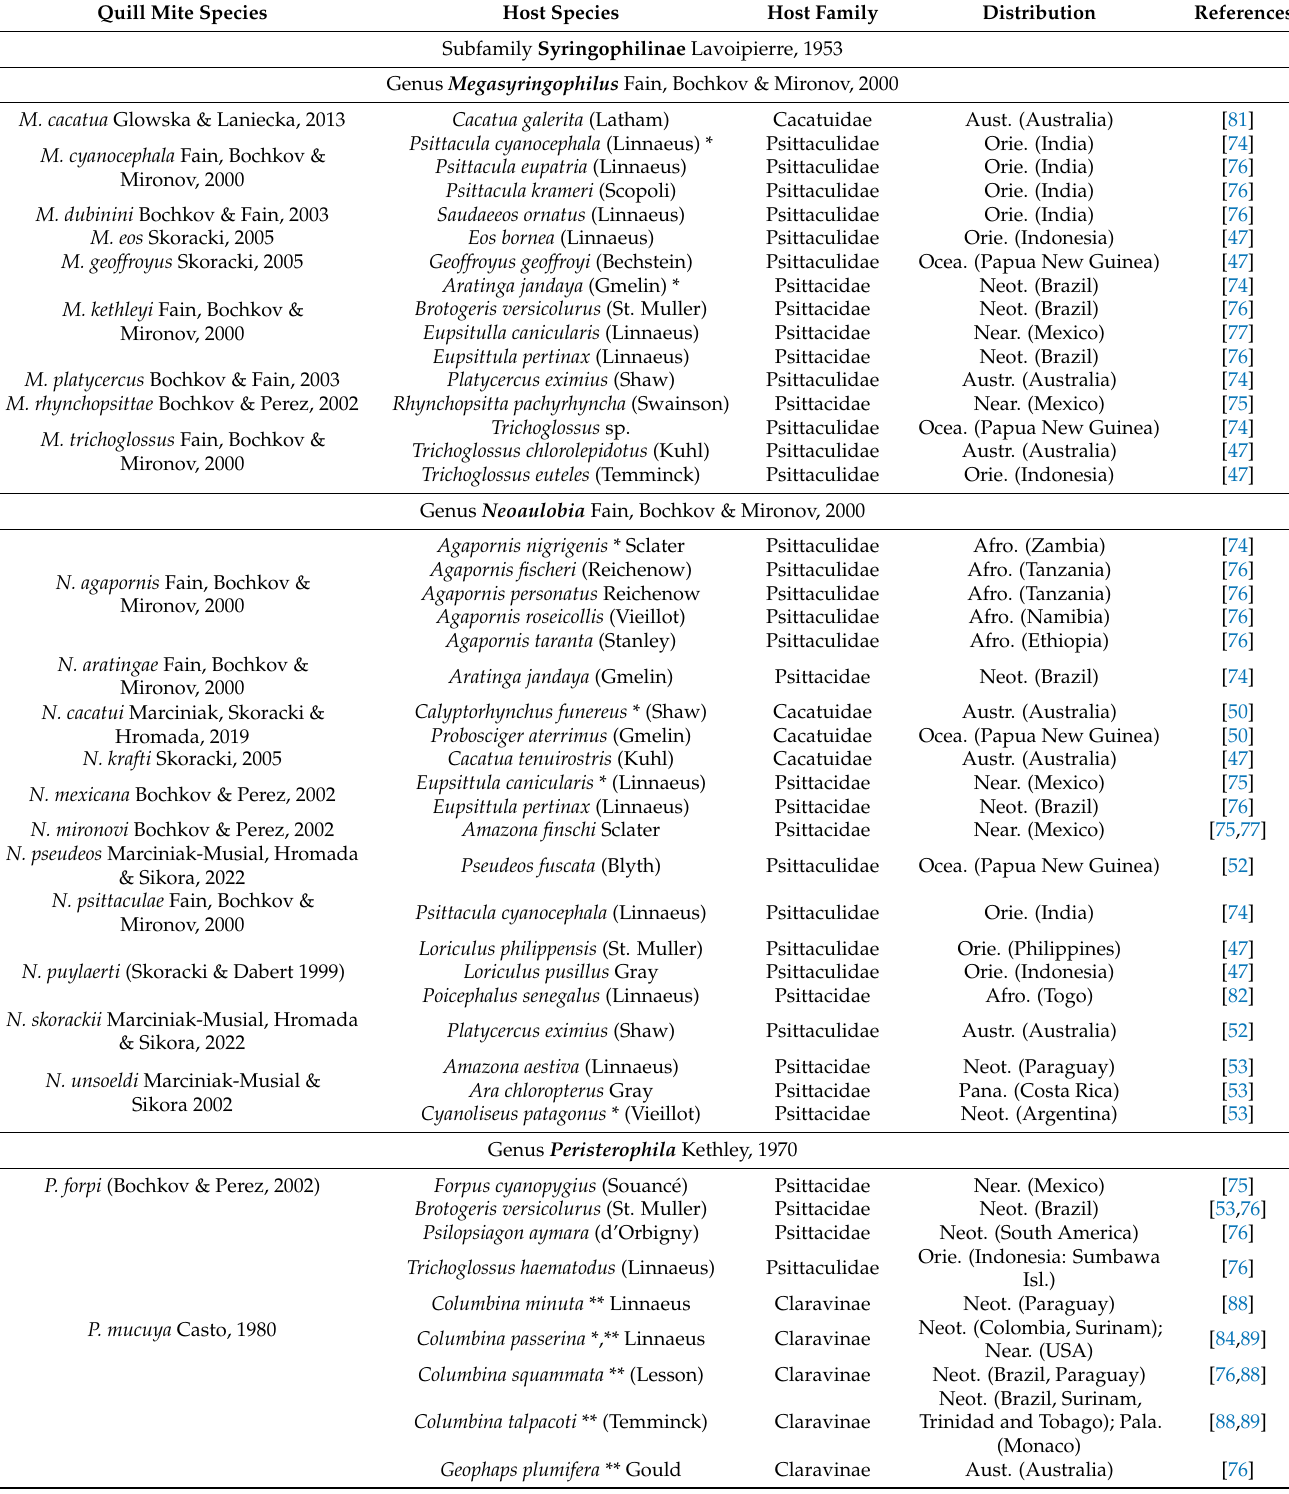
Table 1. Quill mite species of the family Syringophilidae parazitising birds of the order Psittaciformes with their